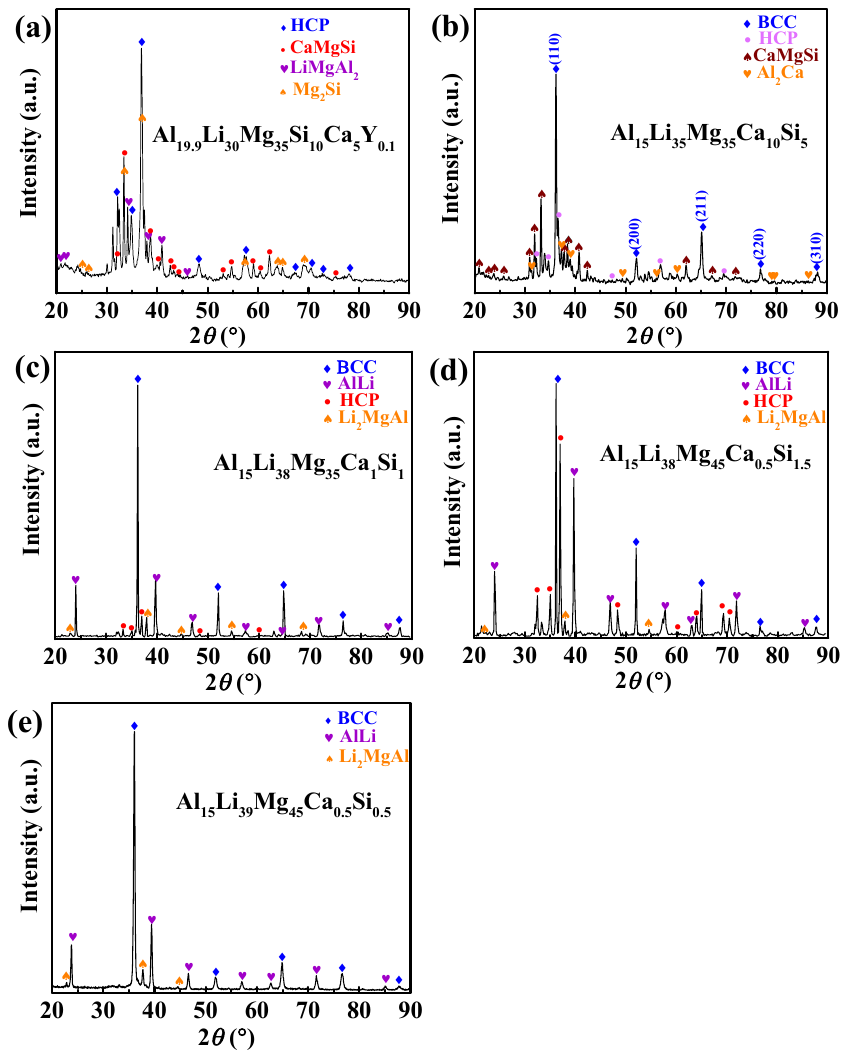
Figure 2. X-ray diffraction patterns of five ULW-CCAs. ( a ) Al 19.9 Li 30 Mg 35 Si 10 Ca 5 Y 0.1 ULW-CCA; ( b ) Al 15 Li 35 Mg 35 Ca 10 Si 5 ULW-CCA; ( c ) Al 15 Li 35 Mg 48 Ca 1 Si 1 ULW-CCA; ( d ) Al 15 Li 38 Mg 45 Ca 0.5 Si 1.5 ULW-CCA; ( e ) Al 15 Li 39 Mg 45 Ca 0.5 Si 0.5 ULW-CCA.